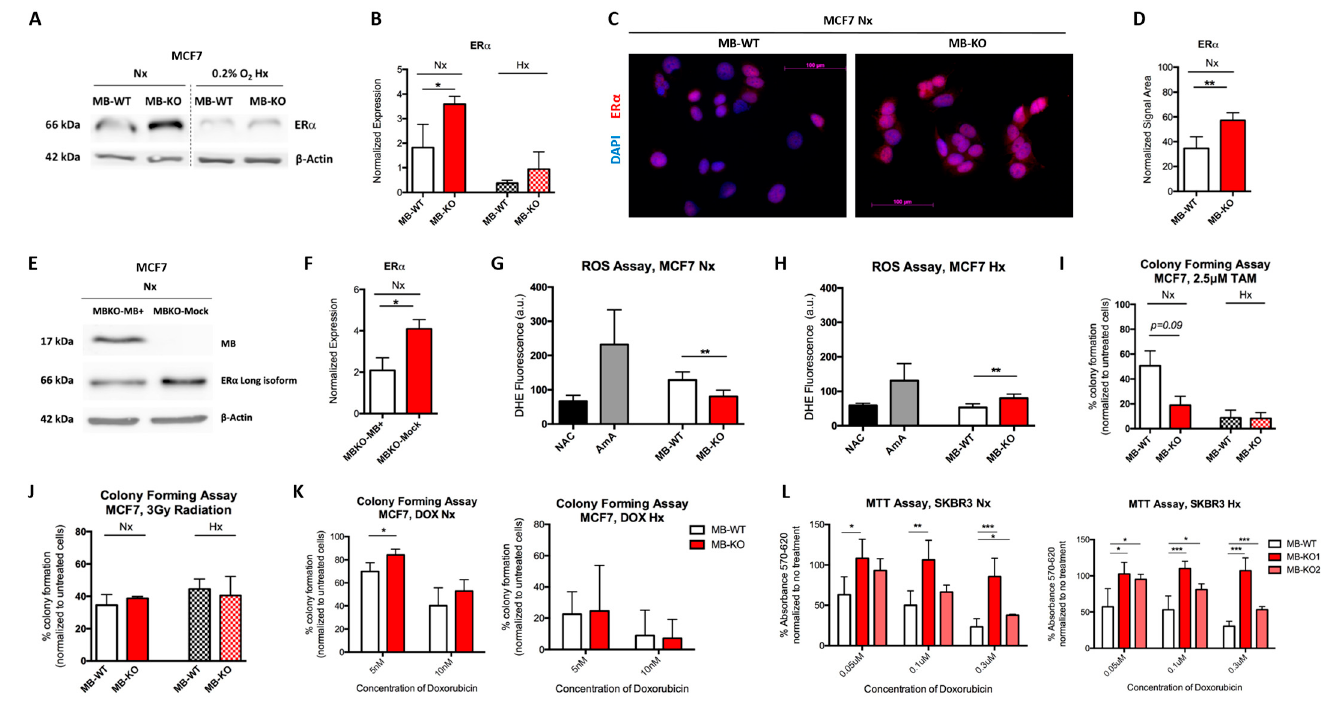
Figure 3. Myoglobin interferes with estrogen receptor expression, ROS generation, and response to chemotherapeutic but not irradiation treatment. ( A ) Representative Western blotting image of whole tissue lysate of MB-WT and MB-KO clones of MCF7 cells cultured at normoxia (Nx) or 0.2% O 2 hypoxia (Hx) for 72 h and stained for estrogen receptor alpha ER α (60 kDa) and β -actin (42 kDa) used as the loading control ( n = 4). ( B ) Band intensity of ER α protein after Western blotting, from MB-WT (white) and MB-KO (red) cells of MCF7 at Nx (empty bars) and 0.2%O 2 Hx (dashed bars), was quantified using MCID Analysis 7.0 and normalized to β -actin ( n = 4). ( C ) Representative immunocytochemistry images of MB-WT and MB-KO MCF7 cells stained for ER α (red) and DAPI (blue) after culturing at Nx for 72 h. Scale bar is 100 µm. ( D ) Quantitative analysis of ER α signal area as a percentage of the nuclear signal area ( n = 4). (E) Representative Western blotting image of whole tissue lysate of MCF7 MB-KO cells transfected with MB+ or mCherry plasmids and stained for ER α (60kDa) and β -actin (42 kDa) used as the loading control. (F) Band intensity of ER α after Western blotting, from MB-KO transfected with MB+ (white) or mCherry plasmids (red) cells at Nx, was quantified using MCID Analysis 7.0 and normalized to β -actin ( n = 3). ( G , H ) Fluorescence assay of dihydroethidium (DHE) to measure ROS directly in living cells cultured at Nx or 0.2% O 2 Hx for 72h, respectively. 10,000 cells/well were seeded, in triplicate, in a 96-well plate and incubated at 21% or 0.2% O 2 for 72 h. Antimycin A (AmA), an inhibitor of complex III of the mitochondrial electron transport chain, was included as a positive control for ROS generation. N-acetylcysteine (NAC) was included as an antioxidant negative control. Fluorescence using an excitation/emission wavelength of 500/590 was used ( n = 3). (I,J) Colony assay using MCF7 MB-WT (white) and MB-KO (red) cells seeded at low confluency and treated with 2.5 µM tamoxifen (TAM) (I) or 3Gy irradiation (J). Cells were then incubated in Nx (empty bars) or 0.2% O 2 Hx (dashed bars) for 9 days before colonies (>50 cells) were stained and counted ( n = 4). Data are presented as % of colony forming normalized to untreated. (K) Colony assay using MCF7 MB-WT (white) and MB-KO (red) cells seeded at low confluency and treated with 5 or 10 nM Doxorubicin. Cells were then incubated at Nx or 0.2% O 2 Hx for 9 days before colonies (>50 cells) were stained and counted ( n = 4). (L) MTT assay using SKBR3 clones. Cells were incubated in Nx (left panel) or 0.2% O 2 Hx (right panel) with 0.05, 0.1, and 0.3 µM doxorubicin for 72 h. After the addition of MTT, absorbance was measured and normalized to cell number (determined by growth curve experiments) ( n = 4–6). Data are presented as mean and standard error of mean and analyzed by Student t-test except for SKBR3 data in panel (L) by One-way ANOVA with Tukey’s multiple comparison post-hoc analysis * p < 0.05, ** p < 0.01, *** p < 0.001.